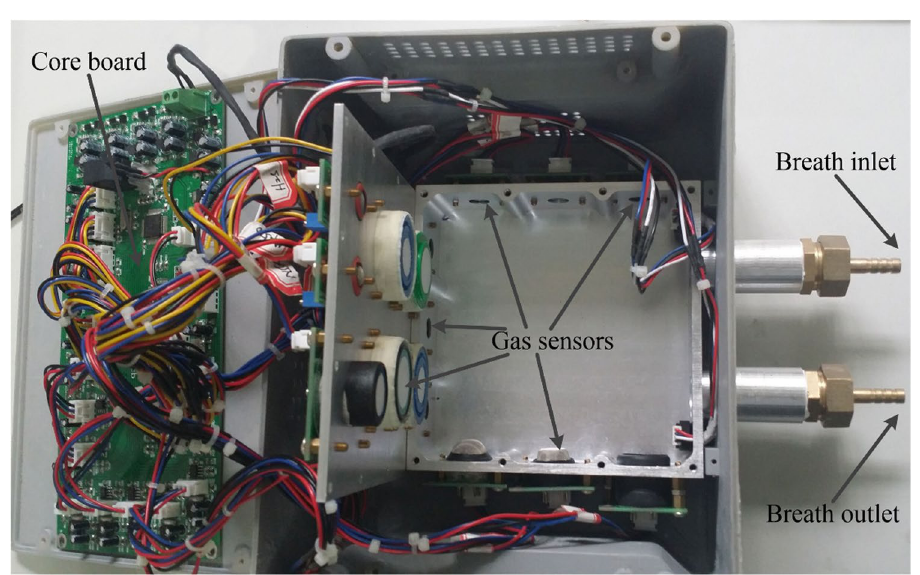
Figure 1. The photo of the designed E-nose